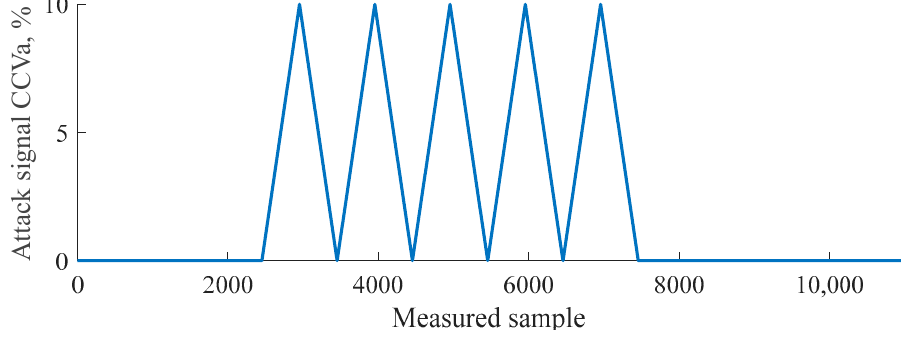
Figure 4. Triangular attack signal.